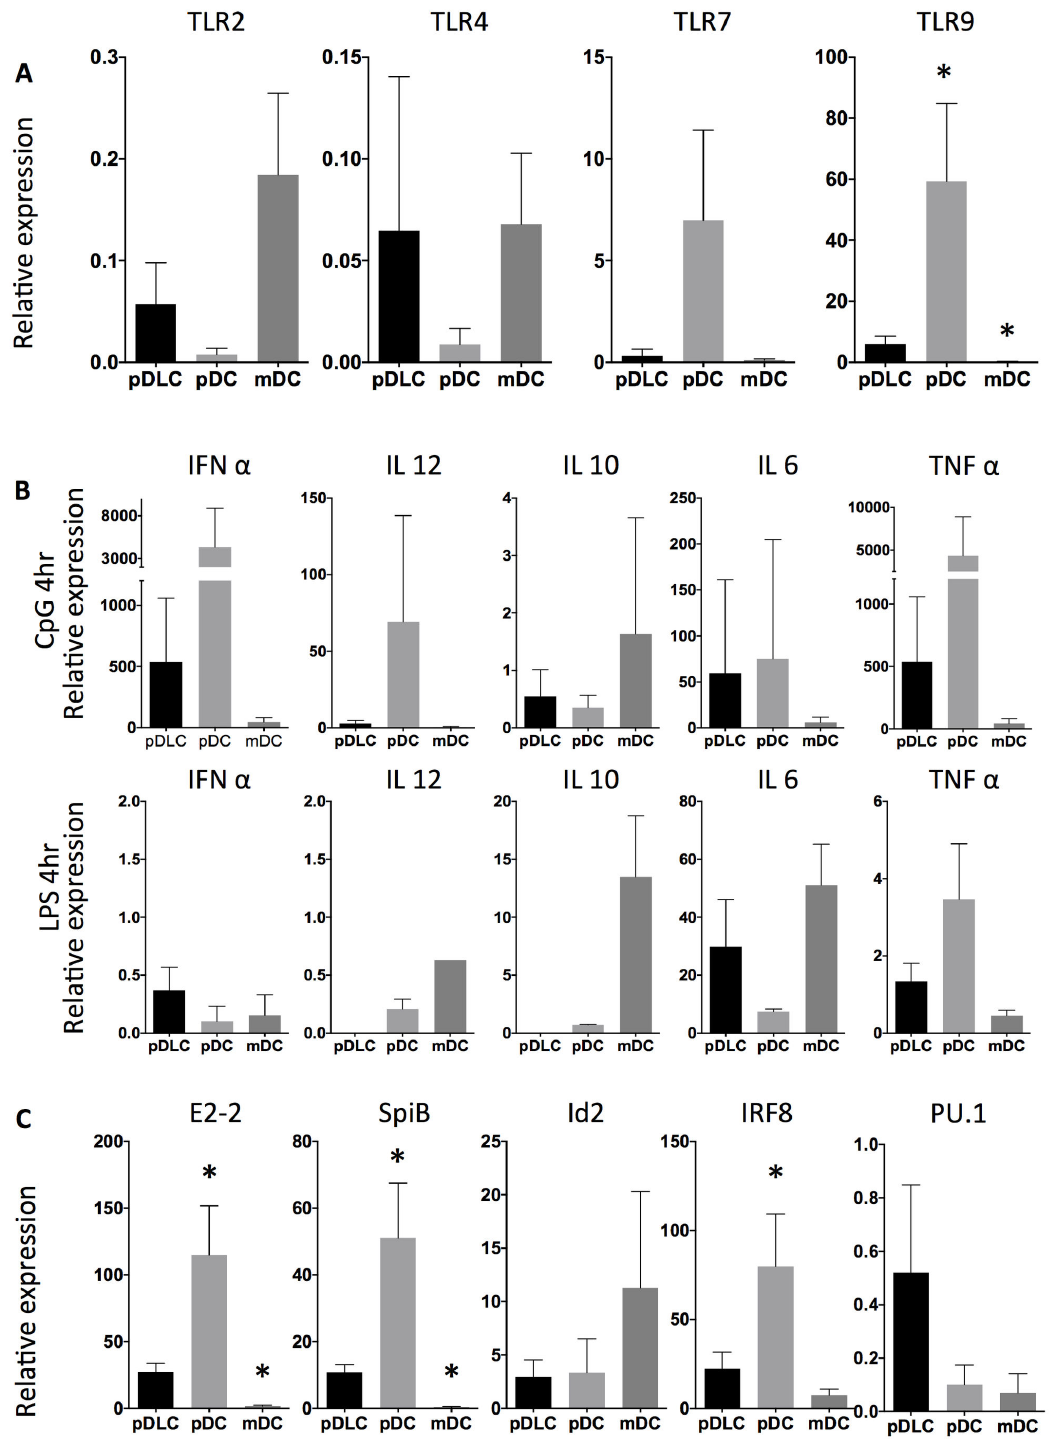
Figure 3. TLR, cytokine, and transcription factor expression levels in pDLCs are distinct from pDCs and mDCs. qRT-PCR analyses were performed using cDNA from pDLCs, pDCs, and mDCs. Results were standardized using PBMC cDNA (n=5). * P < 0.05 compared to pDLC. (A) TLR expression analysis revealed that mDCs expressed TLR2 and TLR4, whereas pDCs expressed TLR7 and TLR9. (B) Cytokine production was analyzed after CpG or LPS stimulation. (C) Transcripts of E2-2, Id2, Irf8, PU.1, and SpiB were analyzed in pDLCs, pDCs, and mDCs. doi: 10.1371/journal.pone.0081722.g003 PLOS ONE |